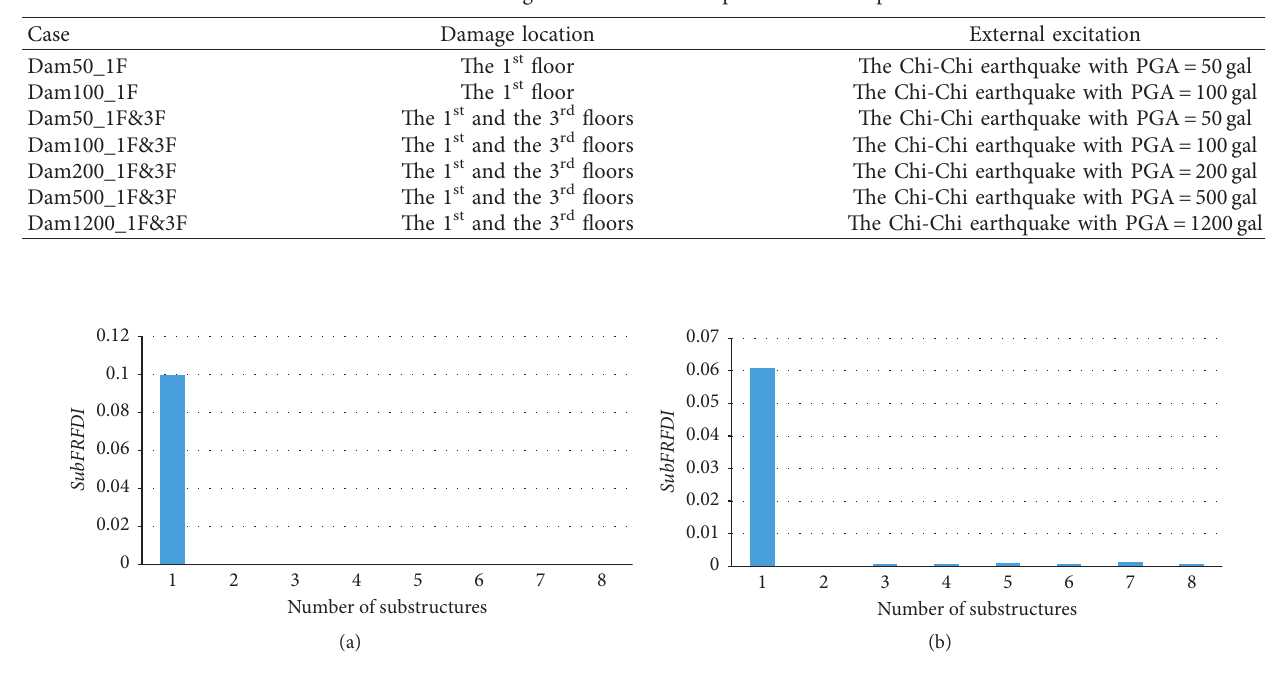
Table 3: Damage scenarios of the experimental example.